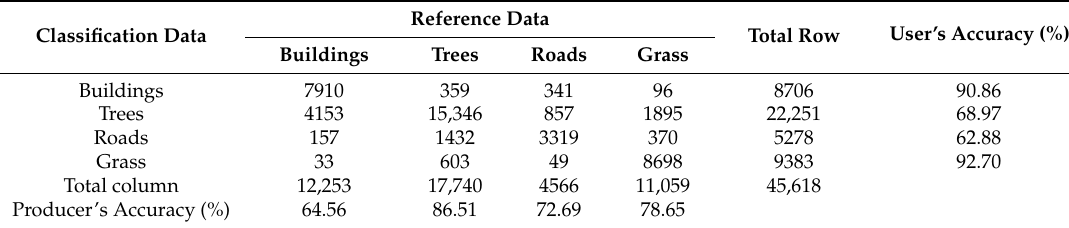
Table 3. Confusion matrix for CIBs.